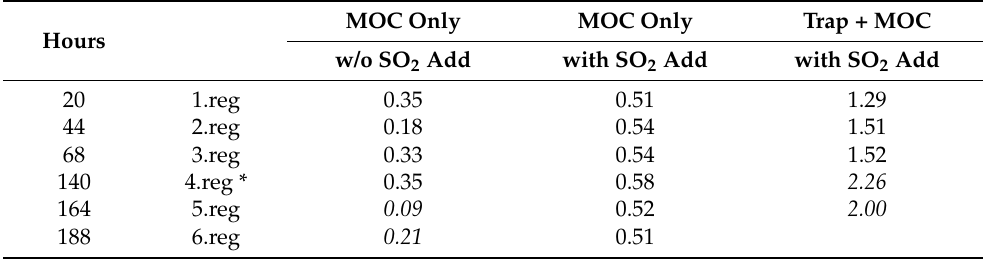
Table 3. The SO 2 amounts (g) released during regenerations. * Note. 4.reg was done after weekend. In case of Italic labelled values, engine-driving mode was not exactly as intended, see text for more details. MOC Only MOC Only Trap + MOC Hours w/o SO 2 Add with SO 2 Add with SO 2 Add 20 1.reg